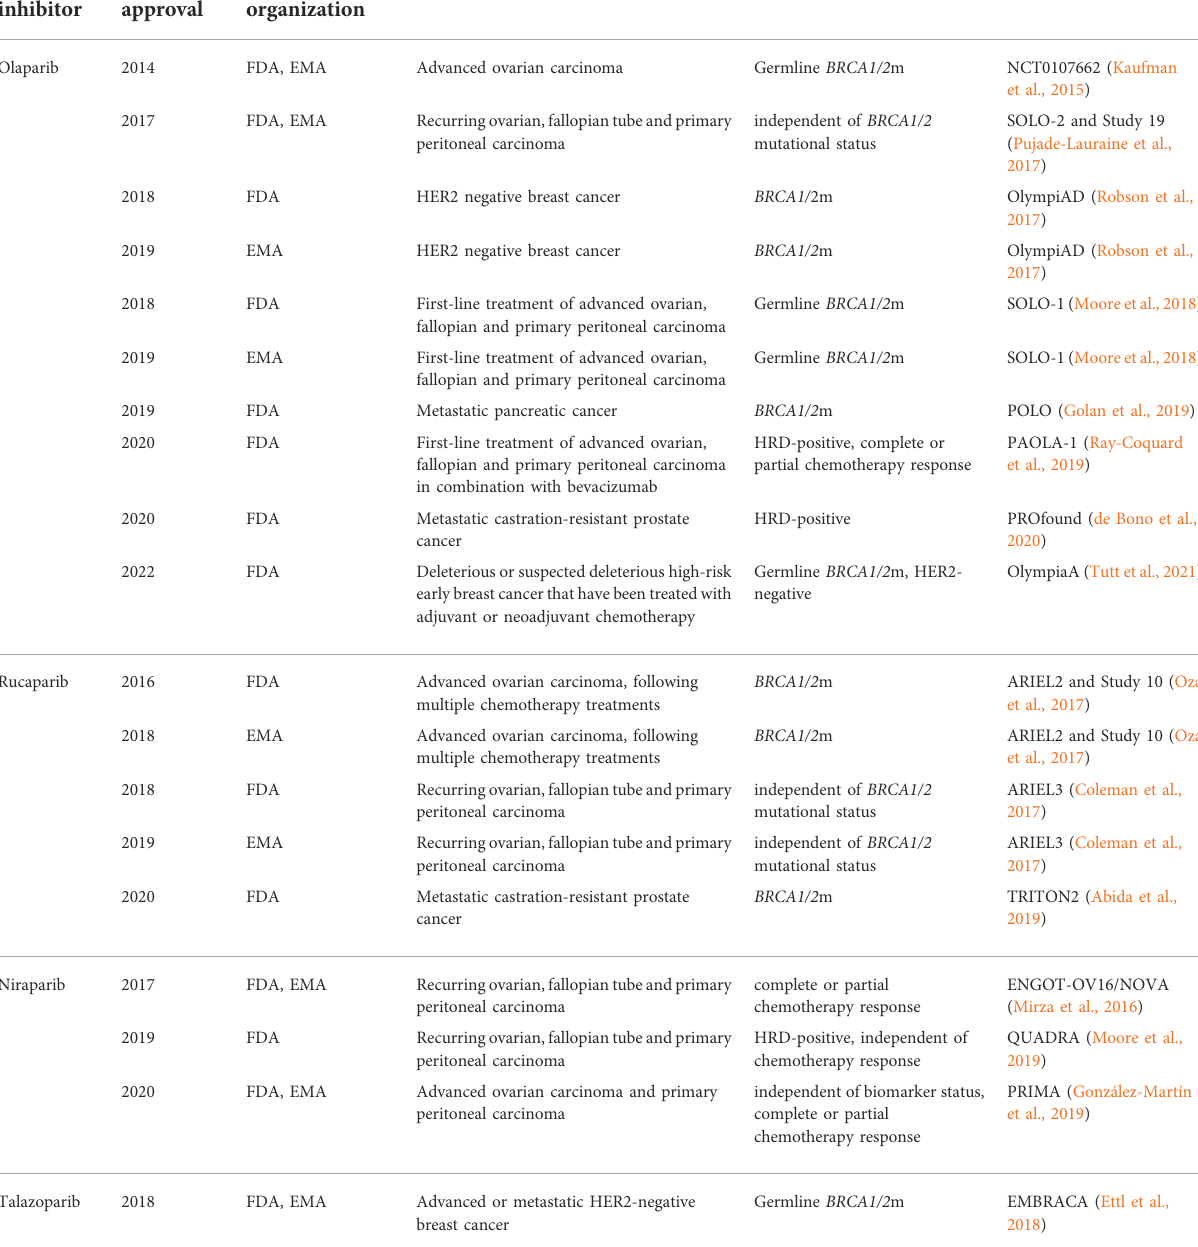
TABLE 1 History of PARPi in the clinic – European Medicines Agency (EMA) and Food and Drug Administration (FDA) approvals. Full access to the research studies description is available on ClinicalTrials.gov. PARP